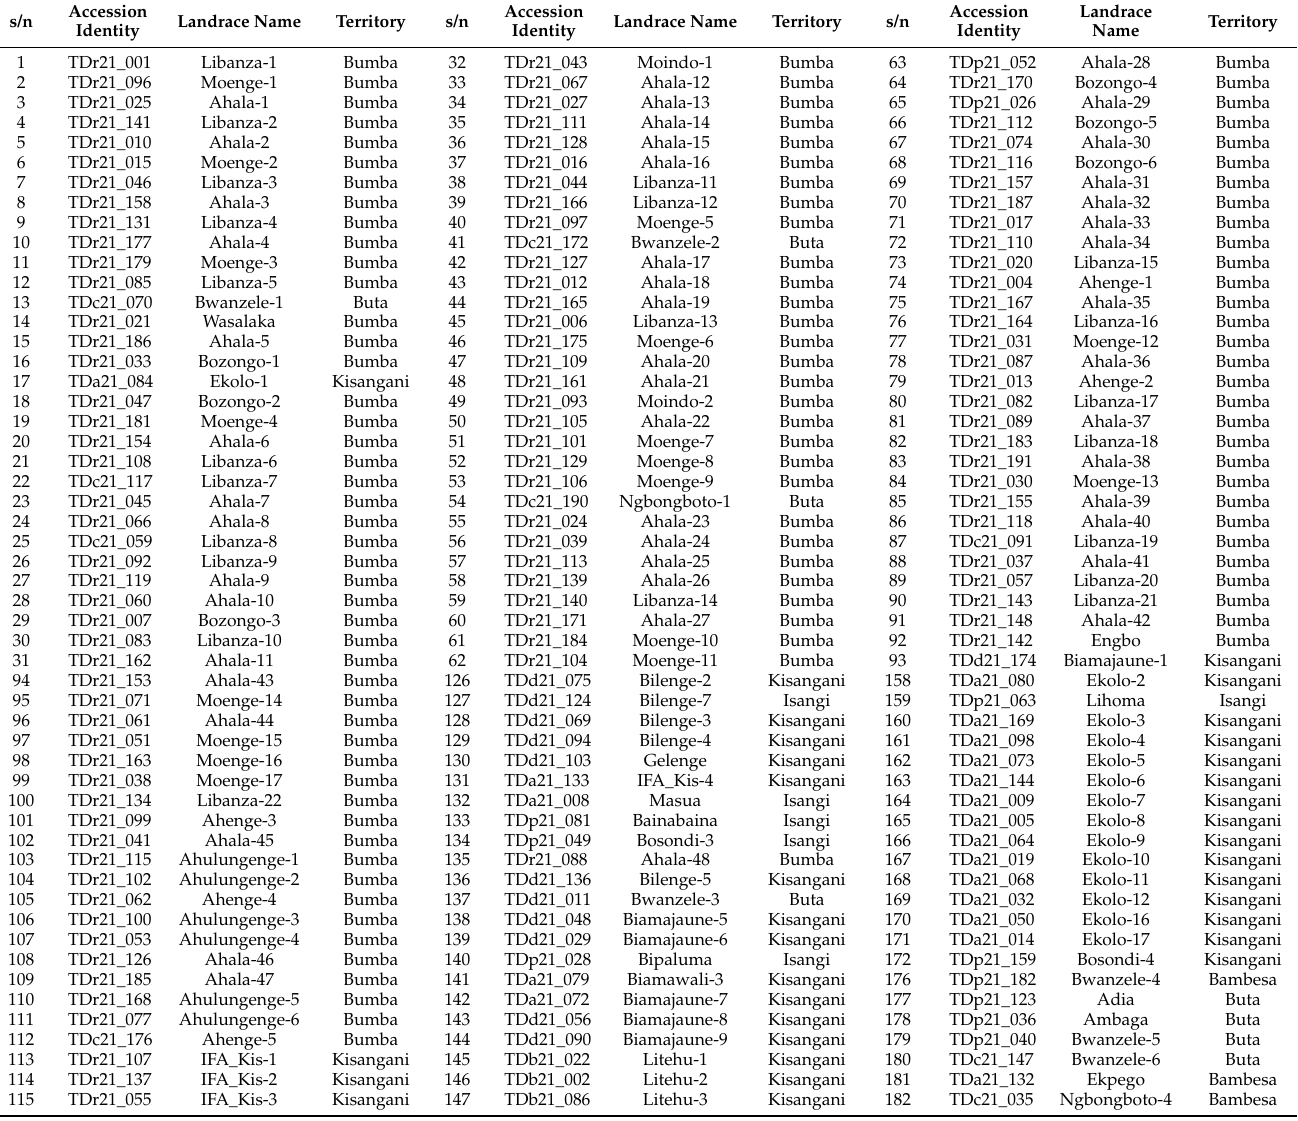
Table 1. List of the panel of 191 yam accessions used for the trial